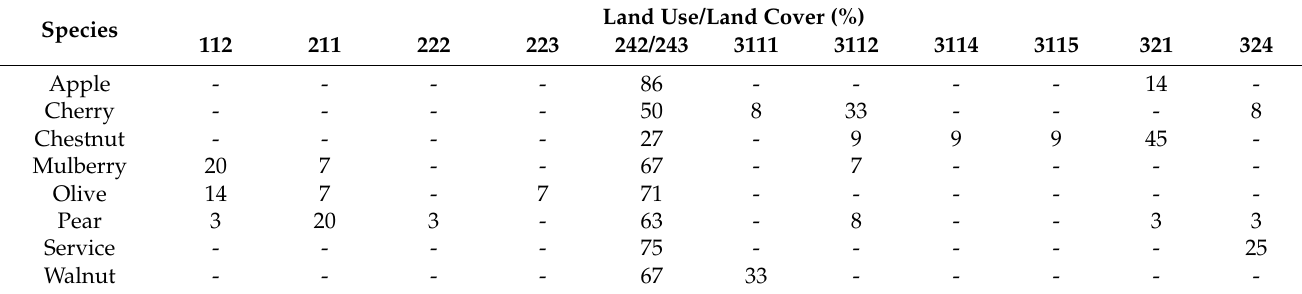
Most old fruit trees were located in heterogeneous agricultural areas, which include complex cultivation patterns, forming a mosaic landscape where cultivated lands mix with semi-natural ecosystems (Table 2). Olive and mulberry trees could also be found in the discontinuous urban fabric category (Table 2). Old olive and chestnut trees were rarely located in olive groves and chestnut stands, and many chestnut trees lie in the shrub and/or herbaceous vegetation association (Table 2). Cherry, walnut and service trees were often recorded in forests or transitional woodland categories (Table 2). Table 2. Land use and land cover features of fruit tree locations. Land use and land cover data were extracted from the Corine Land Cover (2018 v. 2020_20u1). Numbers indicate the CLC category: 112 = Discontinuous urban fabric; 211 = Non irrigated arable land; 222 = Fruit trees and berry plantation; 223 = Olive groves; 242/243 = Heterogeneous agricultural areas; 3111 = Broadleaved forest (Holm oak and/or Cork oak); 3112 = Broadleaved forest (Turkey oak and/or Downy oak and/or Hungarian oak and/or Pedunculate oak); 3114 = Chestnut forest; 3115 = Beech forest; 321 = Shrub and/or herbaceous vegetation associations; 324 = Transitional woodland